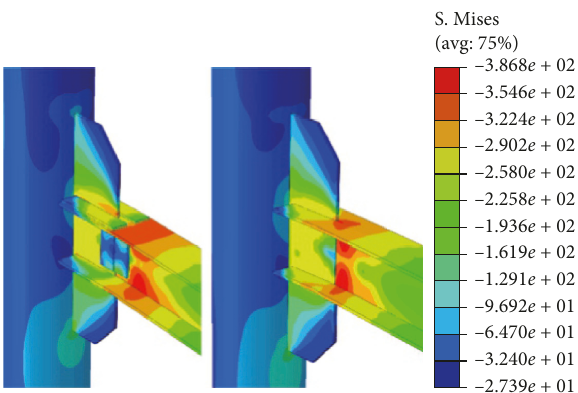
Figure 16: Stress nephograms of specimens SJ5 and SJ5E.